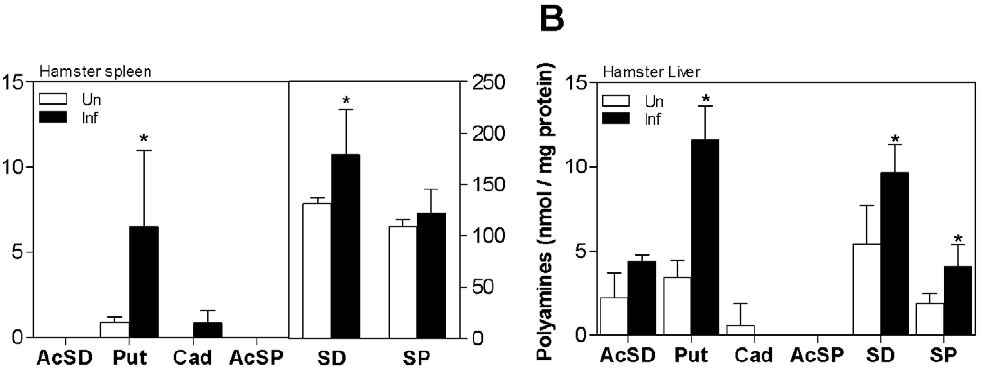
Figure 3. Polyamine content in spleen and liver tissue in L.donovani infected hamsters. The concentration of polyamines in spleen ( A ) and liver ( B ) tissue samples from groups of 6 uninfected hamsters (open bars) and 56 day infected hamsters (filled bars) is expressed as the mean and SD (error bars) of nmol polyamine per mg protein. The data shown are from a single experiment that is representative of 2 independent experiments. The statistical significance of differences in each of the panels is identified by an asterisk (*, p , 0.05).